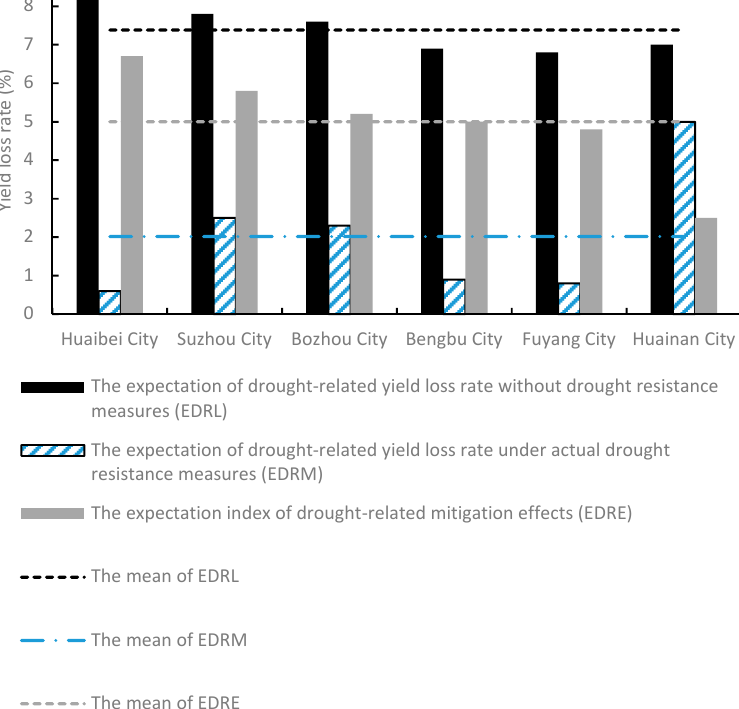
Table 3. Correlations between expectation of drought mitigation effects (EDRE) and its influencing factors in the study site.